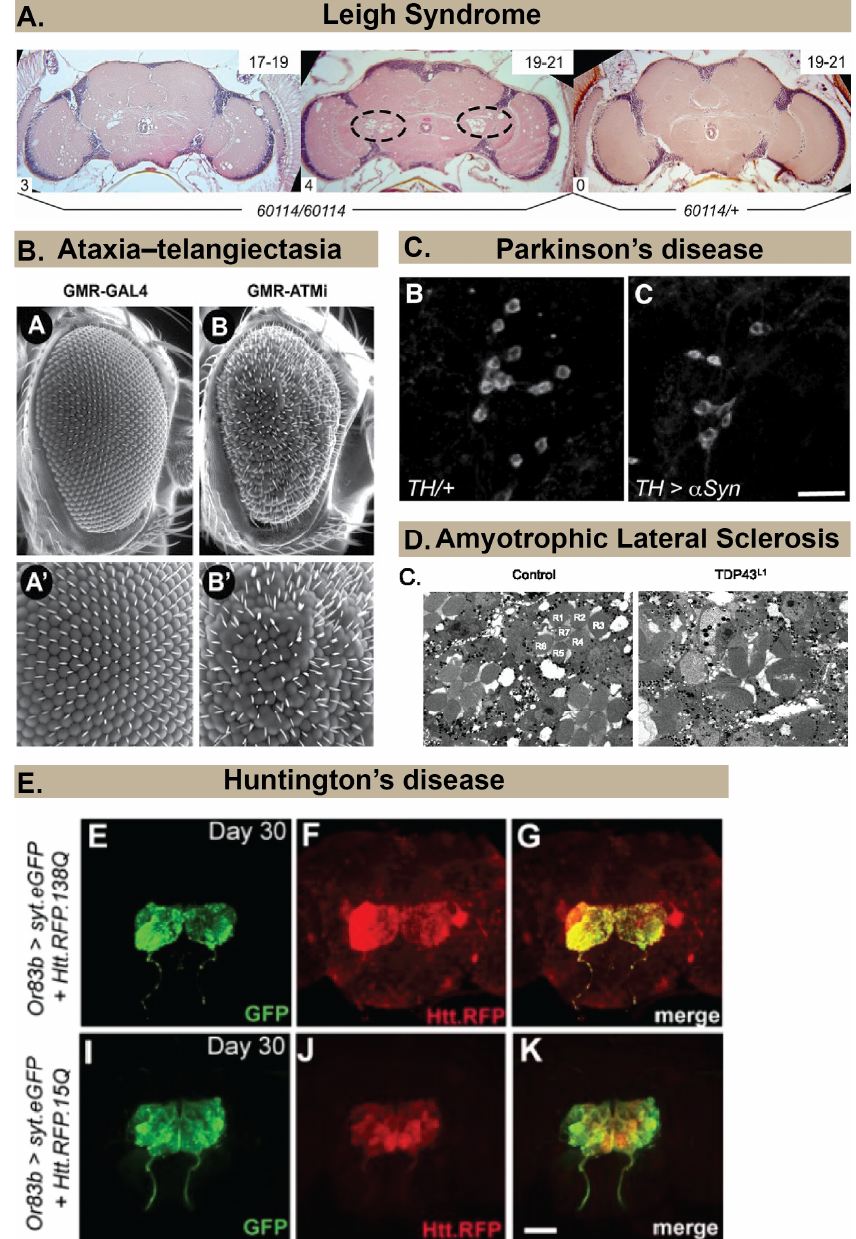
Figure 1. Examples of approaches to examine neuropathology in Drosophila models of di ff erent human neurodegenerative diseases. ( A ) Spongiform pathology in a Drosophila model of Leigh